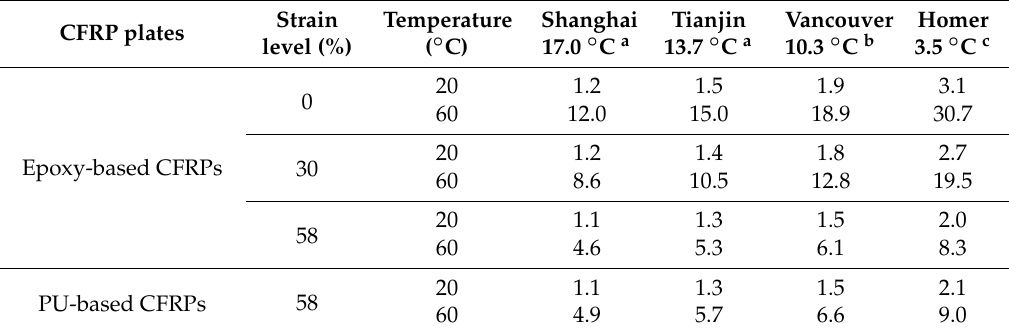
Table 5. Time-shift factors of both epoxy- and PU-based CFRPs immersed in distilled